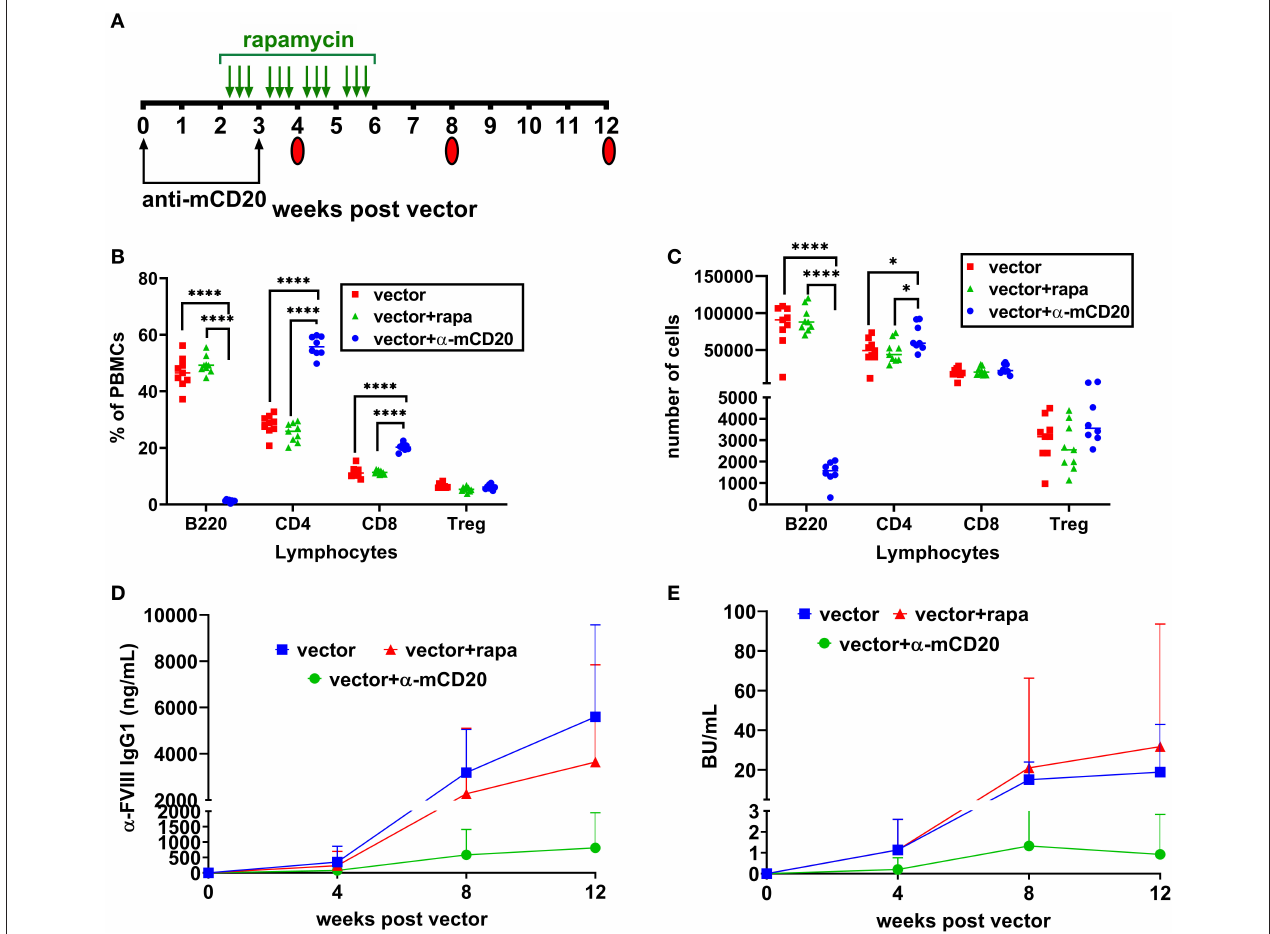
FIGURE 2 | Prophylactic immune suppression with anti-mCD20 or rapamycin is only partially effective at preventing inhibitors. BALB/c-HA mice were divided into three groups ( n = 8 per group), control (red), rapamycin (green), and anti-mCD20 (blue). All groups were IV injected with 1 × 10 11 vg of the AAV8- coF8 vector. Treatment and blood collection time points are indicated in the timeline (A) . Flow cytometry staining of PBMCs was performed at week 4 to stain for B cells (B220 + ), CD4T cells (CD4 + ), CD8T cells (CD8 + ), and Treg (CD4 + CD25 + FoxP3 + ), and data is reported as frequency of PBMCs (B) and total cell counts (C) . Anti FVIII IgG1 levels (D) and Bethesda inhibitor titers (E) over time. A p < 0.05 was considered statistically significant, and indicated as follows: * p < 0.05, ** p < 0.01, *** p < 0.001, and **** p <